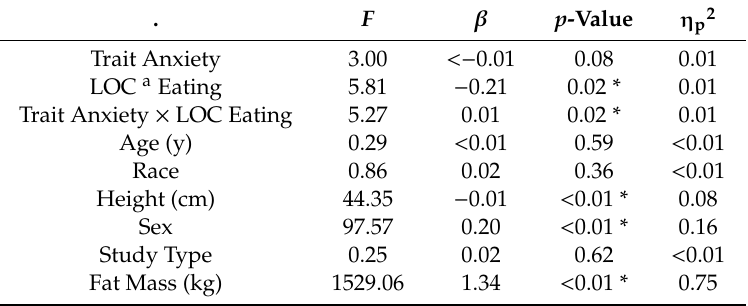
Table 2. Loss of control (LOC) Eating, Trait Anxiety, and Interaction Effects on Fasting Serum Leptin.